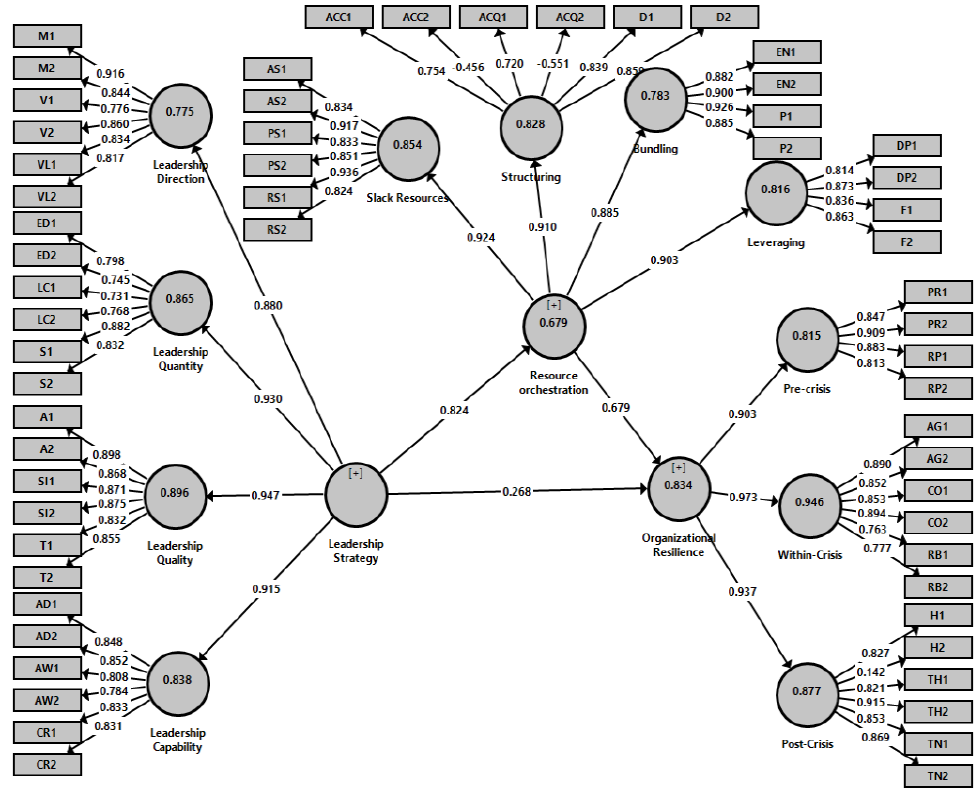
Figure 10: Model Path Coefficients of Aggregated Resource